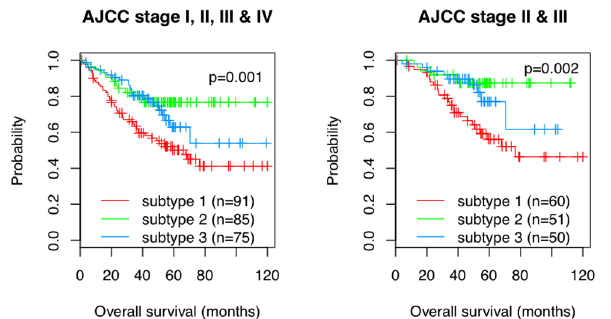
Figure 4. Kaplan-Meier plots of overall survival of patients from three CRC subtypes. Combining data from Moffit Cancer center, Vanderbilt Medical center and Max Planck Institute as a single cohort, we got 251 samples totally (left panel) and 161 samples from CRC stage II and III (right panel).